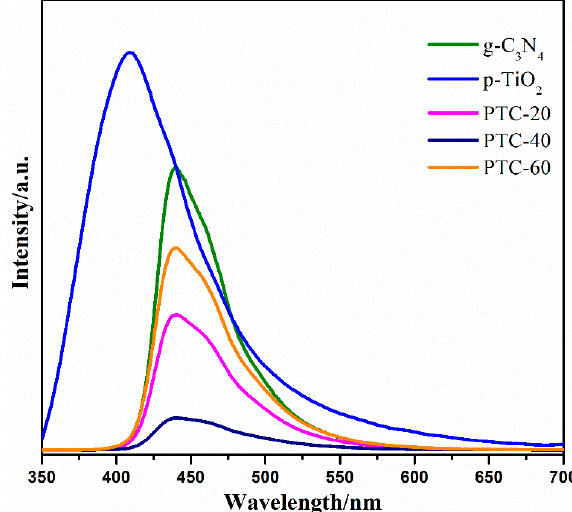
Figure 8. Steady state PL spectra of layered g-C 3 N 4 , PTC-20, PTC-40 and PTC-60.